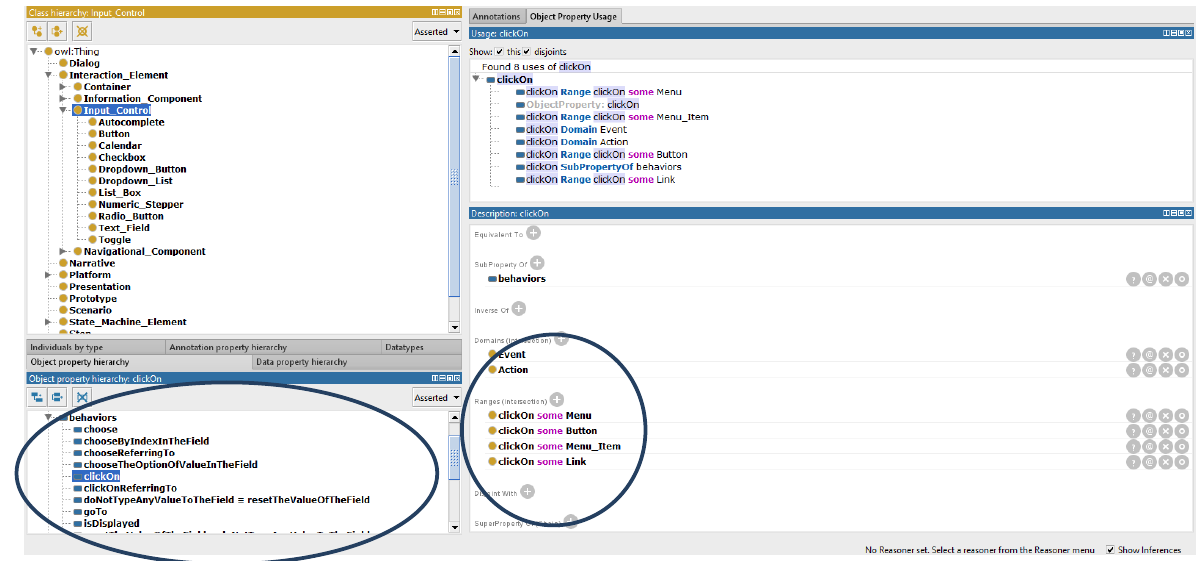
Figure 6. Ontology representation: (a) Overall View, (b) State Machine Concepts